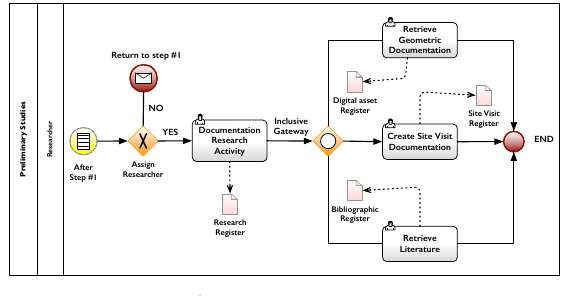
Figure 2. BPD: Step 2